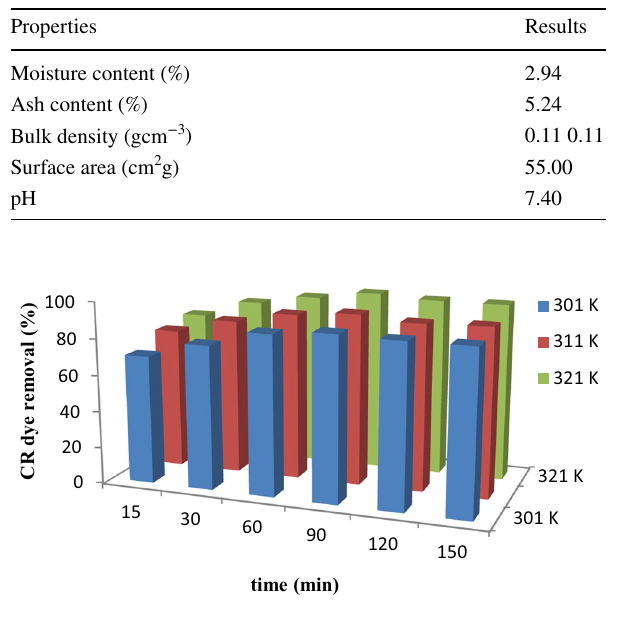
Fig. 5 Effect of contact time on percentage CR dye removed from aqueous dye solution at different temperatures